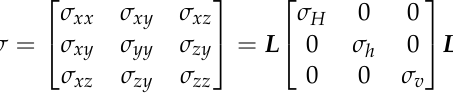
Figure 2. Coordinate transformation of inclined-vertical shaft (modified from Gao et al. [33]).